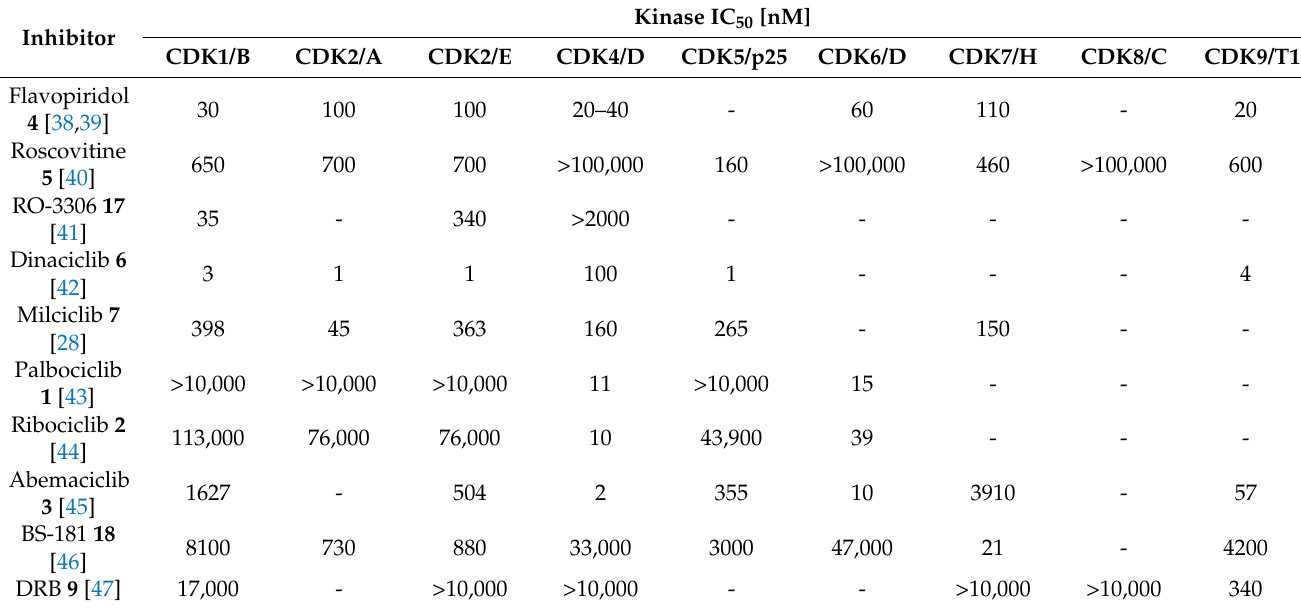
Table 1. Kinase inhibitory activities of type I CDK